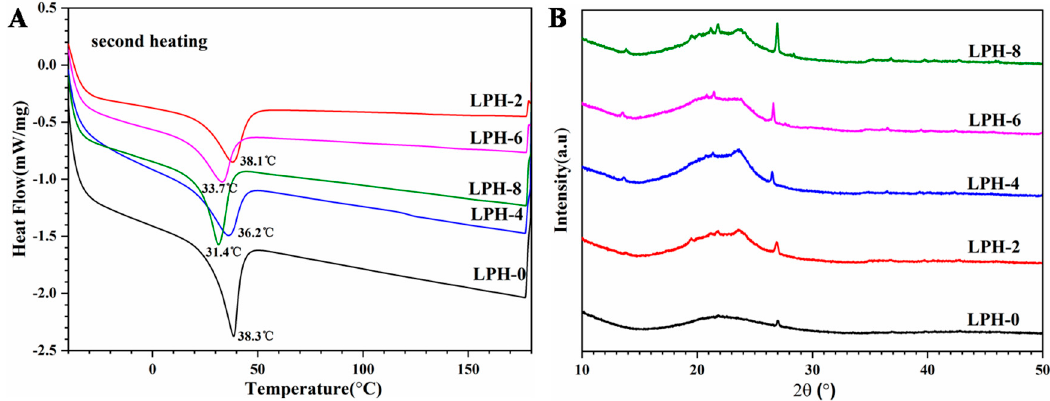
Figure 5. ( A ) The DSC and ( B ) XRD of the LPH films. Table 2. Thermal parameters of LPH filmsby TGA and DSC measurements.